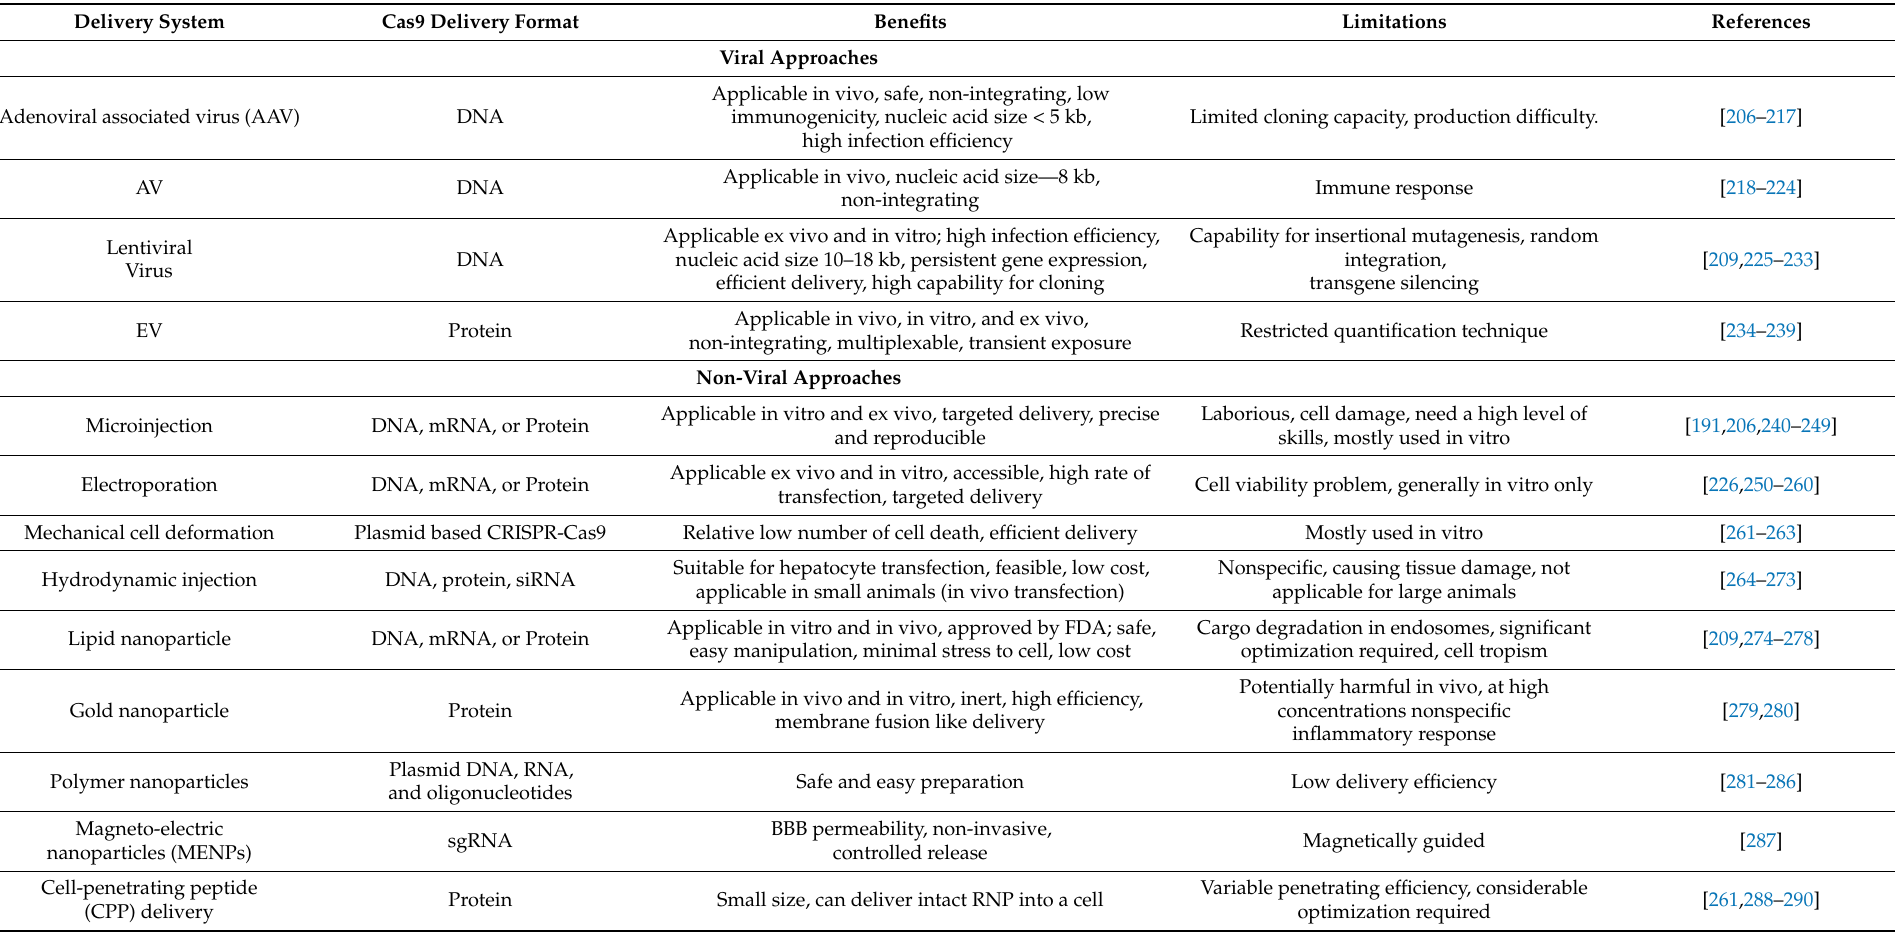
Table 2. Summary of various delivery systems for